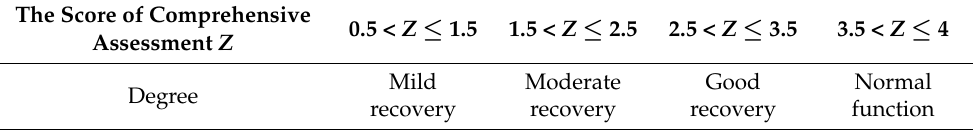
Table 6. Relationship between comprehensive assessment score and the degree of finger rehabilita-